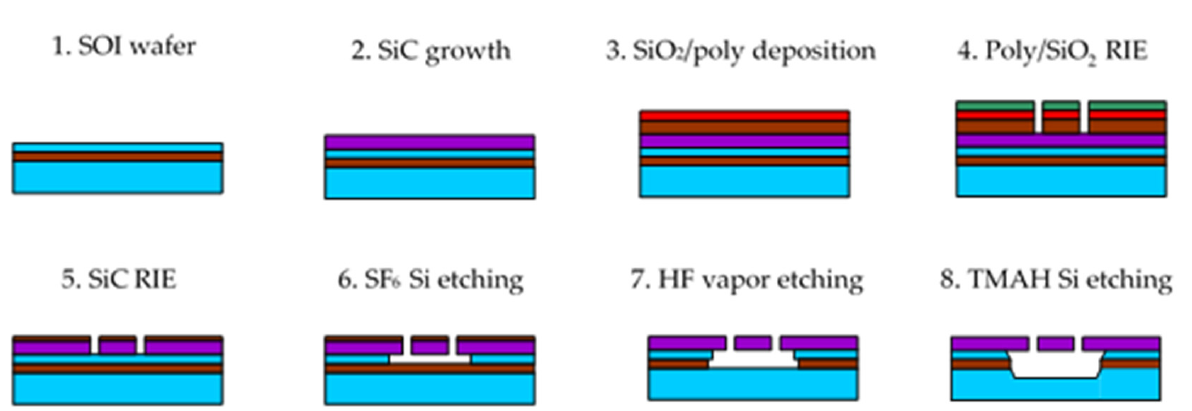
Figure 1. Process flow for the fabrication of the 3C-SiC test structures on SOI wafer.